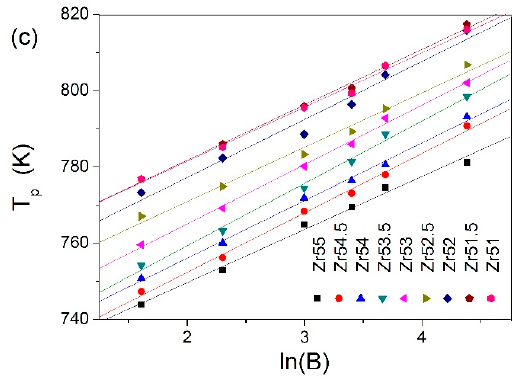
Figure 8. Lasocka plots for: T g ( a ); T x ( b ); and T p ( c ).